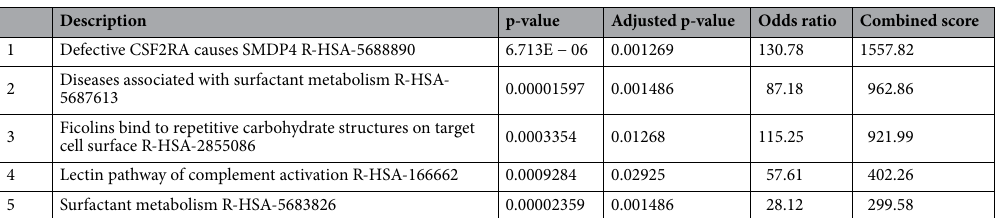
Table 1. Reactome pathway down-regulated DEGs enrichment